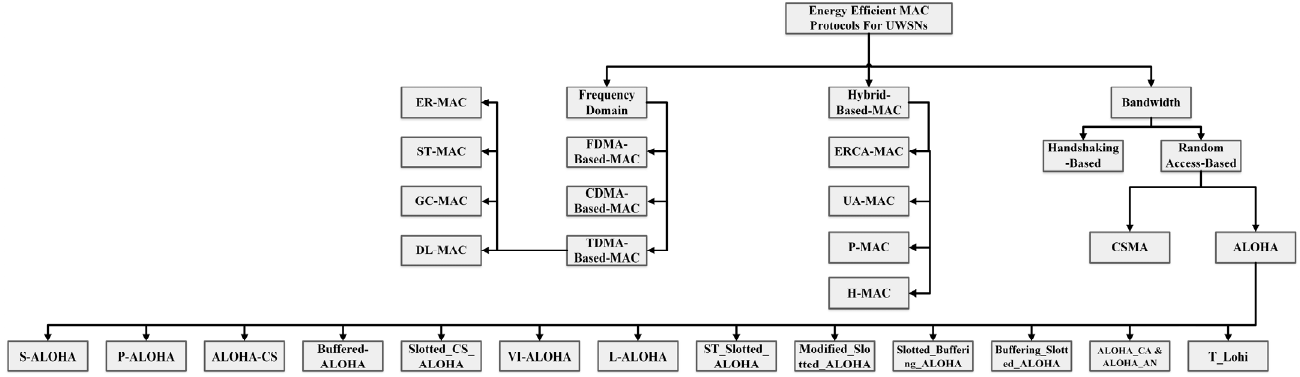
Figure 7. Classification of energy ‐ efficient MAC protocols for UWSNs.